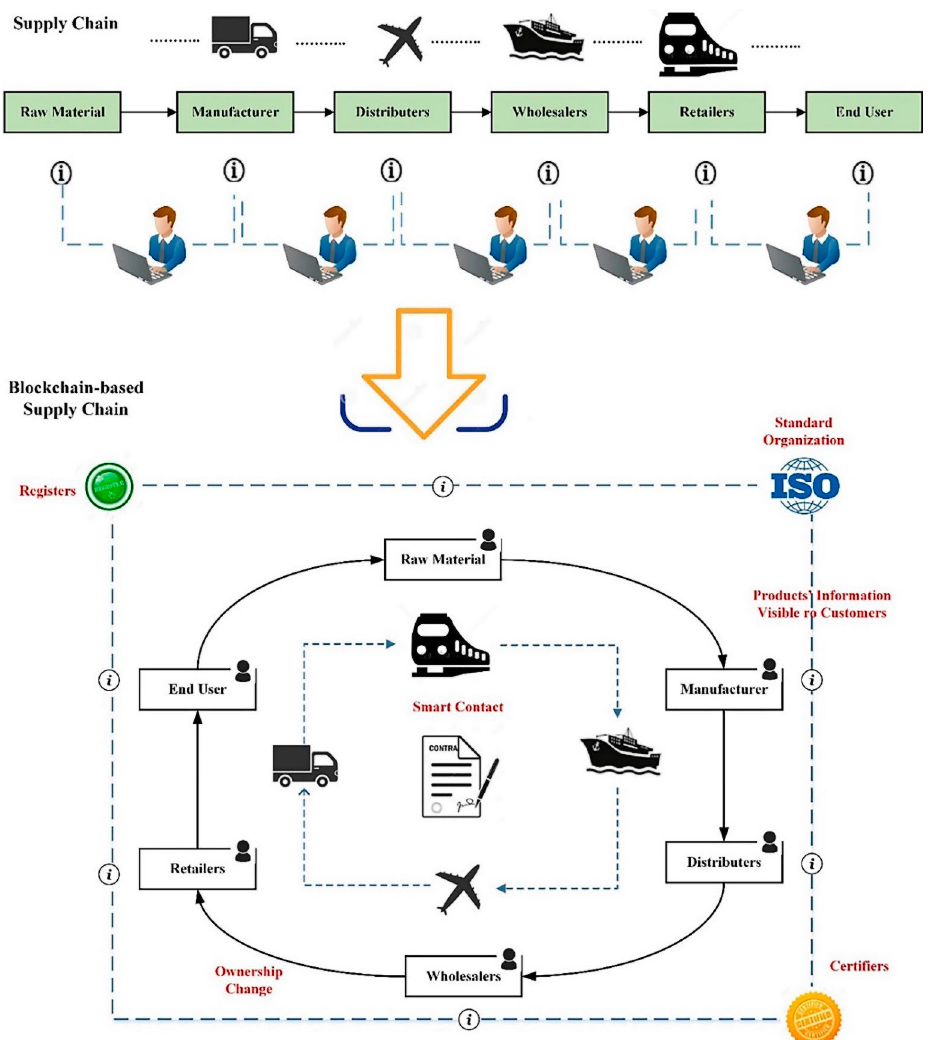
Figure 2. Supply Chain